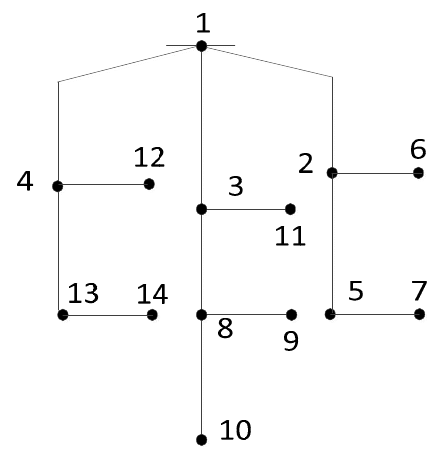
Figure 3. Improved IEEE14 node figure.